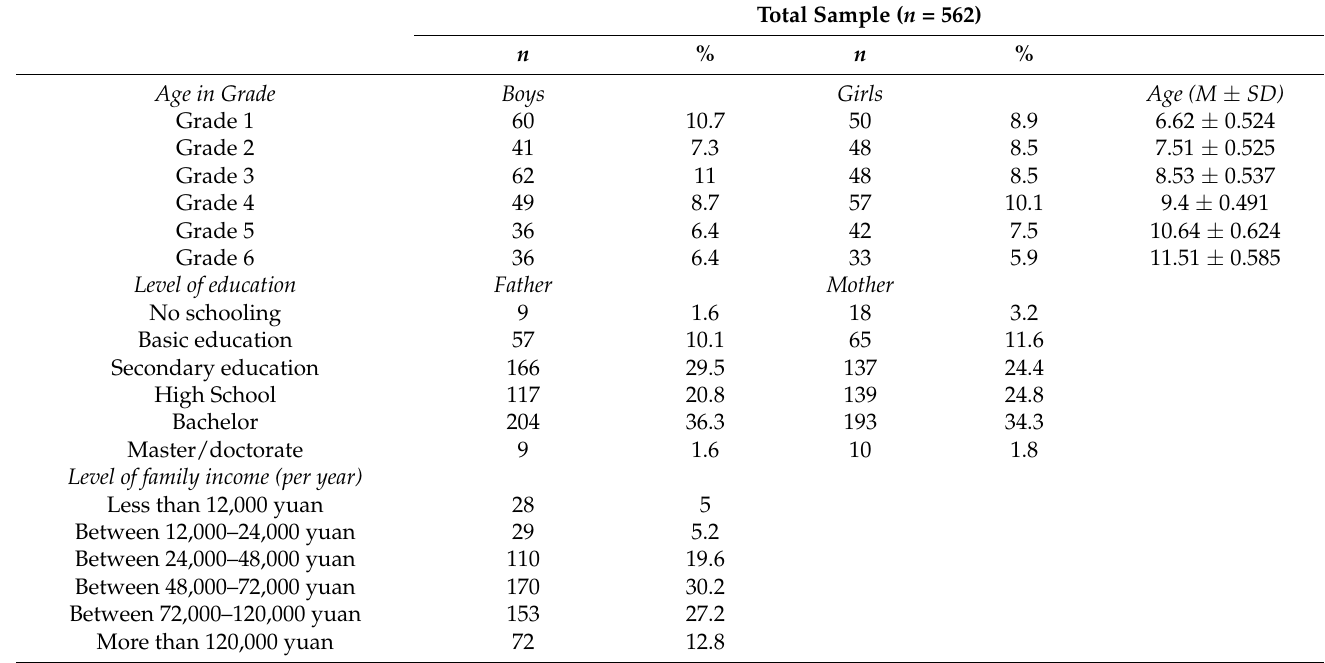
Table 1. Participants’ Demographic